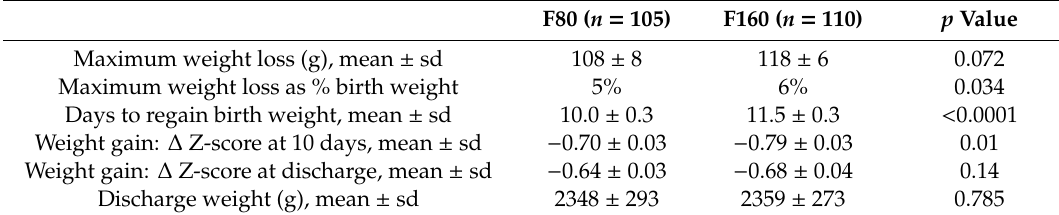
Table 3. Anthropometric findings.